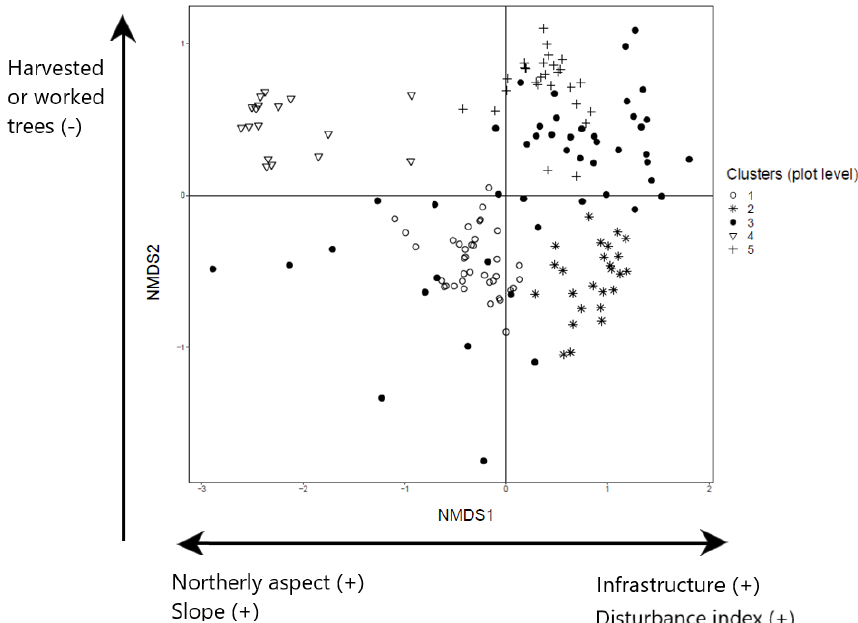
Figure 3. NMDS ordination (axes 1 and 2) of 154 plots across six sacred forests for canopy trees. Plots are labeled according to the five clusters produced by the cluster analysis (1: pine ( Pinus nigra ); 2: mixed oaks (dominated by Quercus coccifera and Q. frainetto ); 3: sclerophyllous species ( Acer monspessulanum, Q. coccifera , and Juniperus oxycedrus ); 4: beech ( Fagus sylvatica ); 5: mixed broadleaves ( Q. pubescens and Carpinus orientalis ). Arrows indicate the main forest prohibition regimes and environmental variables statistically related to the axis coordinates. An increase in the “disturbance index” points to forest prohibition regimes that allow higher levels of disturbance (increased wood removal and